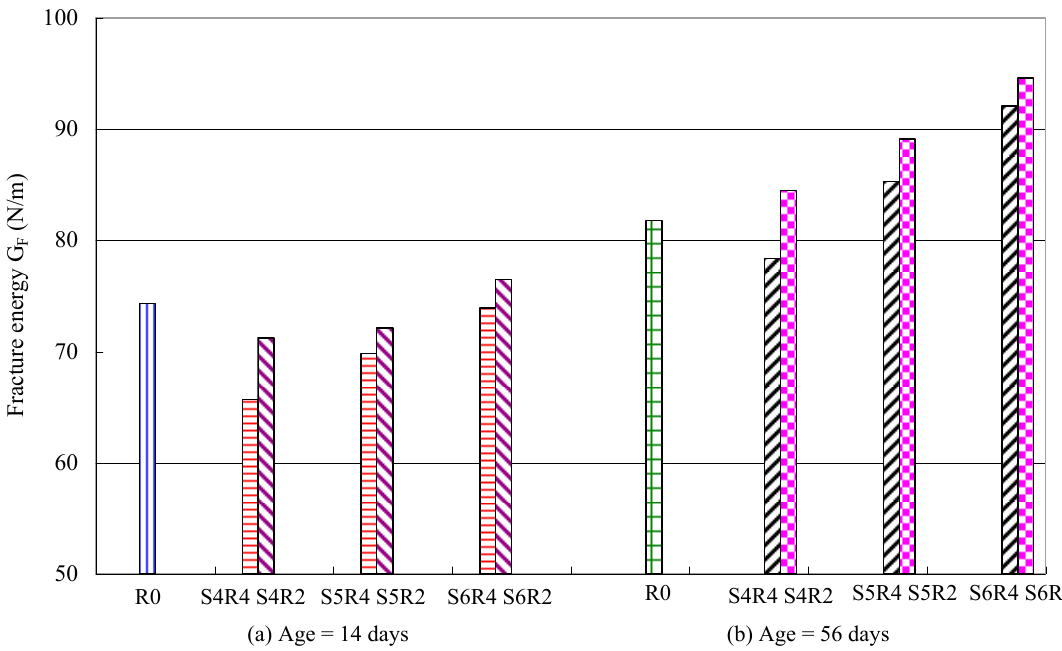
Figure 5. Fracture energy for concretes with various fineness levels and replacement ratios of slag at ages of 14 days and 56 days.